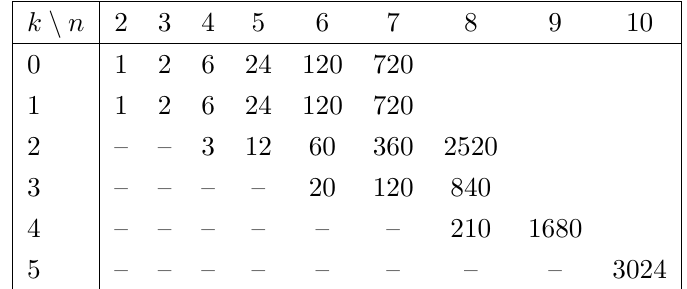
Table 1 . This table lists the size of the basis of primitive amplitudes, or equivalently the number of independent color factors for amplitudes with a closed quark loop. For the cases listed explicit checks have been done for the size of the basis, the number of independent color factors and the color decomposition. The variable n counts the total number of external particles and k denotes the number of quark-antiquark pairs. The numbers are explicitly given by ( n (cid:0) 1)! =k !.